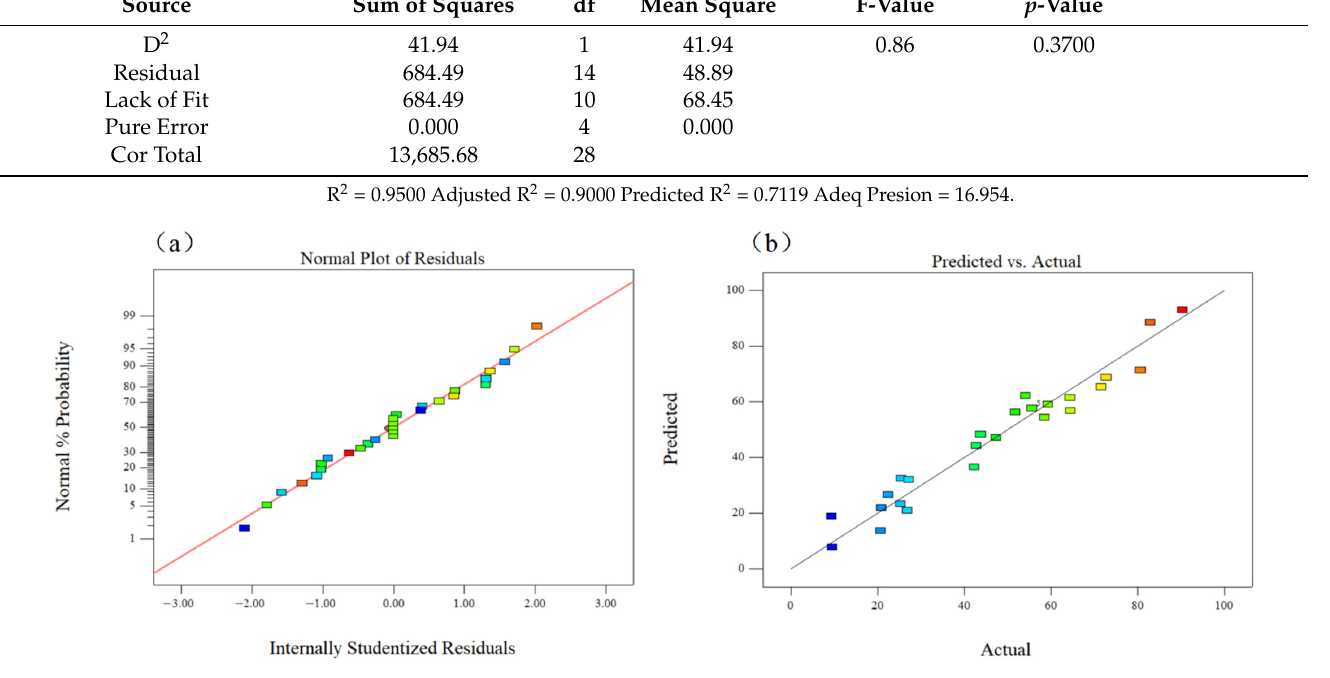
Figure 5. The normal probability plot of studentized residuals of MO of the model for the removal rates ( a ) and the experimental response values versus the predicted response value of MO removal rates ( b ).